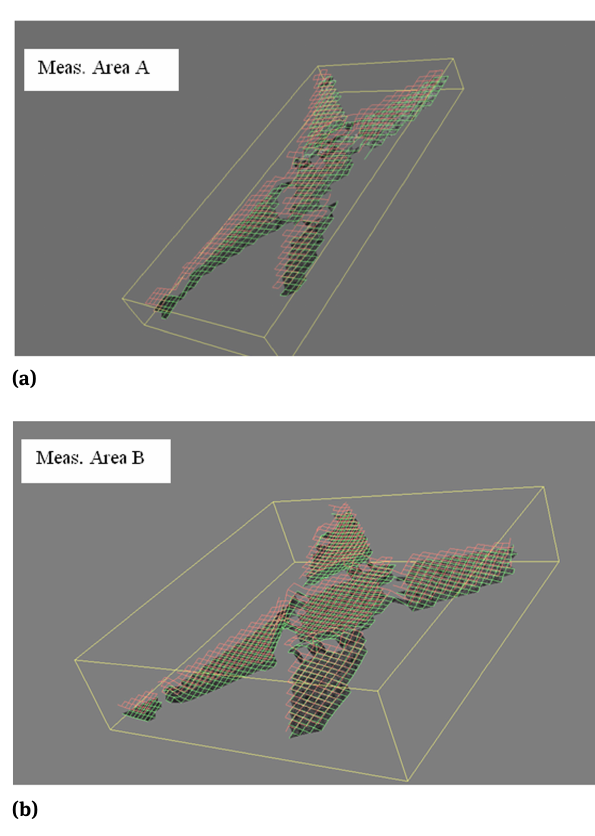
Figure 15: Deformed grids referred to the first and second measure- ment